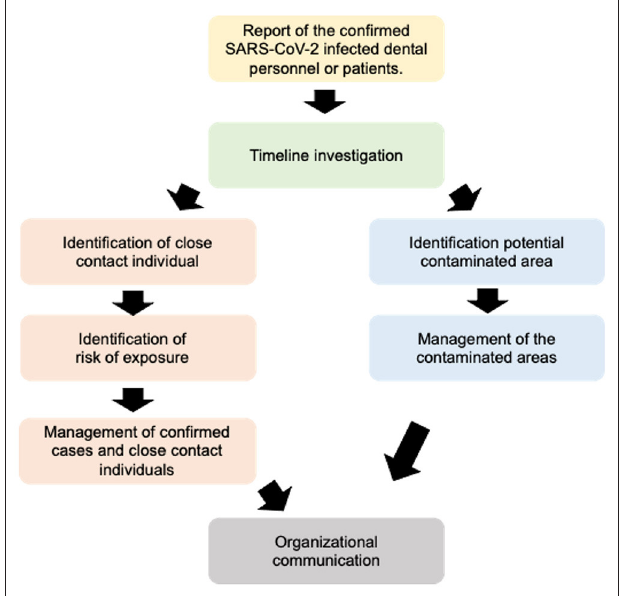
FIGURE 1 | Flow chart illustrating the guideline